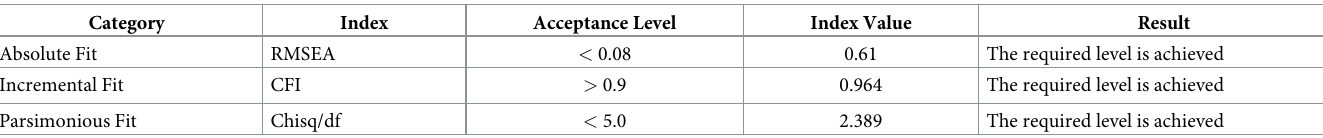
Table 10. Construct validity